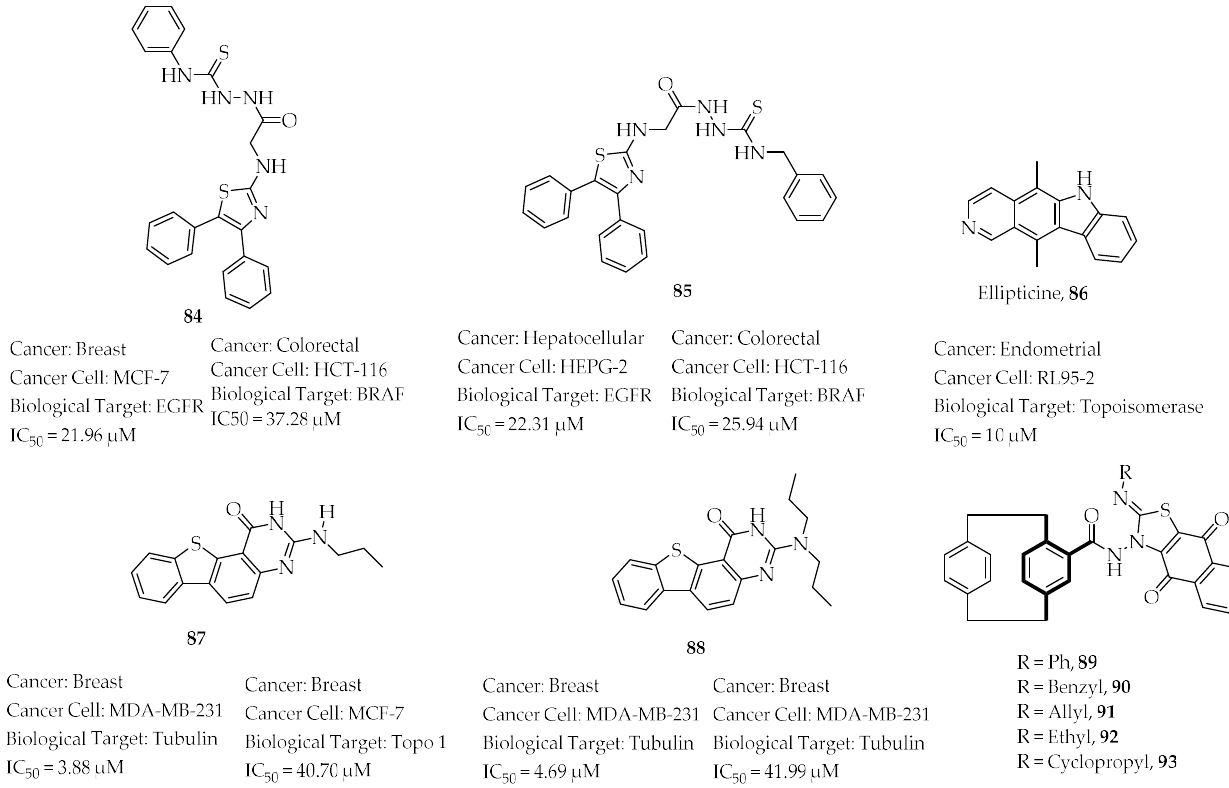
Figure 17. Structures of the diphenyl thiazoles 84 and 85 , ellipticine 86 , benzothienoquinazolinones 87 and 88 with a summary of their biological activity towards selected cancer targets. Table 1. Inhibitory activity of protein kinase enzymes (IC 50 /nM) by synthesized 1,2,4-triazine derivatives [137]. Compound No.